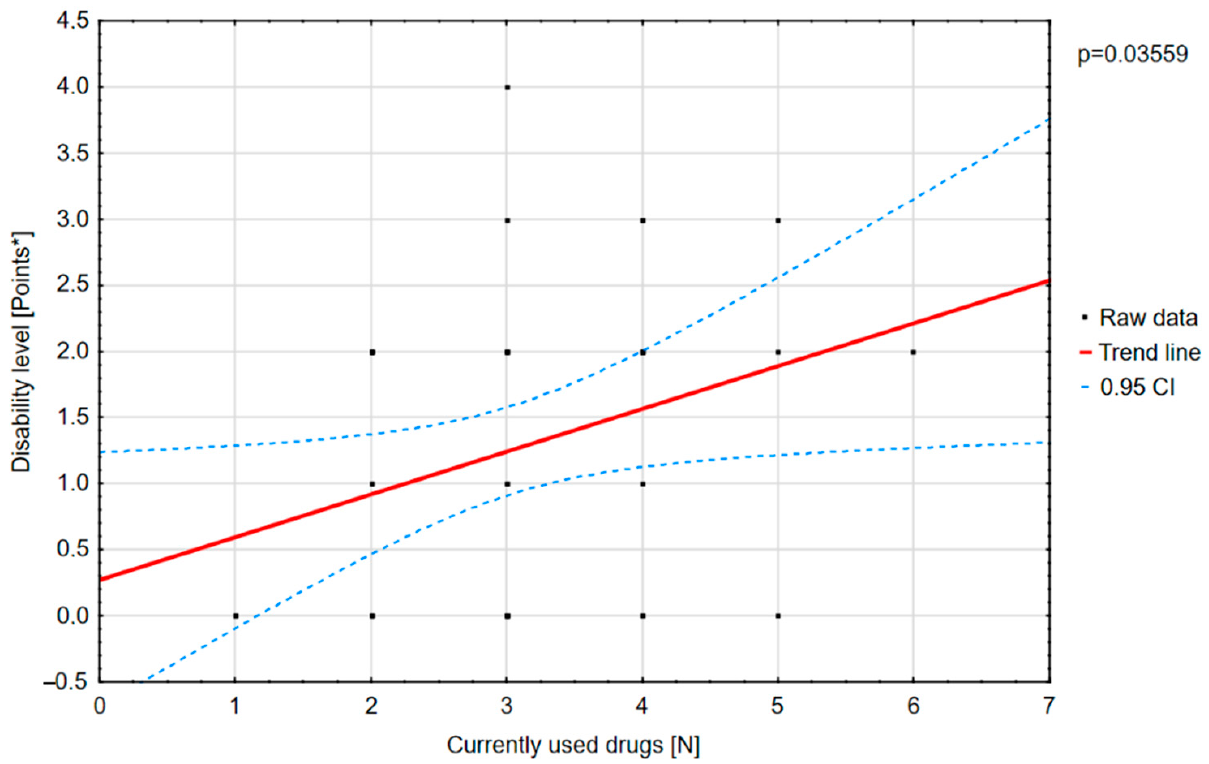
Figure 10. Correlation between the drugs used and the degree of disability.